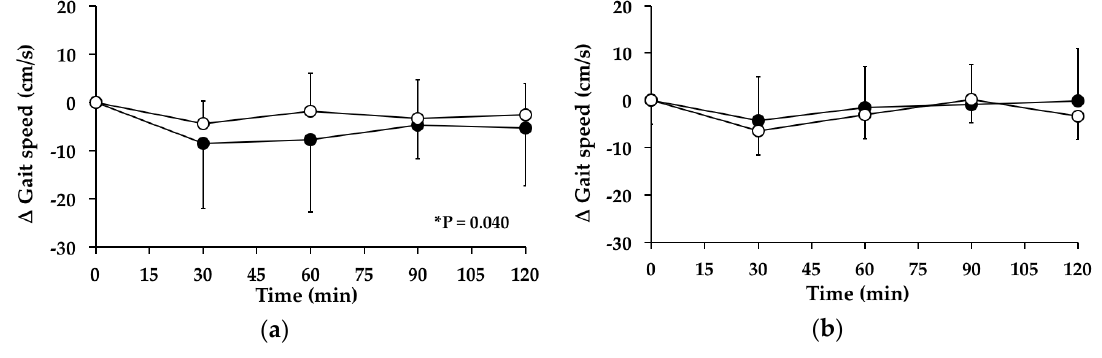
Figure 3. Mean change ( (cid:52) ) in gait speed on “WW” ( ) and “GW” ( ) days in subjects: ( a ) with (cid:35) postprandial hypotension (PPH); and ( b ) without postprandial PPH. Data are mean ± standard deviation (SD) represented by vertical bars. * p = 0.040 for the change in gait speed over time on the “WW” day.